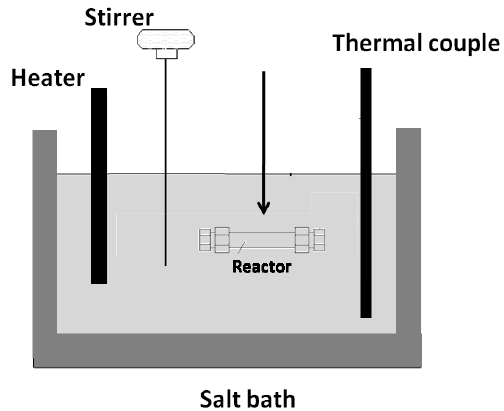
Figure 1. Schematic of experimental system. When CuO was used as the oxidant, the experiments were performed in a Teflon-lined reactor in an oven. The inner volume was 28 mL. The temperature varied from 200 to 250 ◦ C. The reaction time was from 4 to 12 h. The NaOH concentration was 0.1~1.0 mol/L; the molar ratio of guaiacol to CuO was 1.0 and the water filling was 35%. A 200 mesh CuO powder was chosen in this study. In a typical procedure, 2.5 mmol of CuO